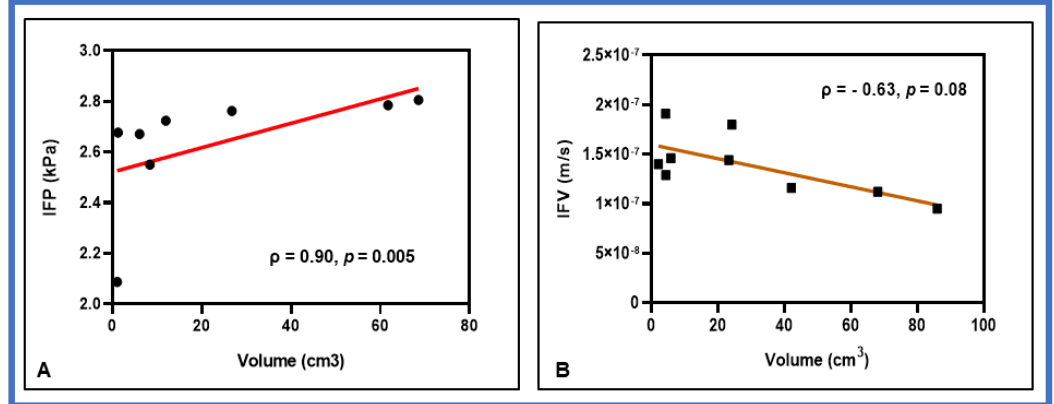
Figure 4. Representative correlation plots between CFM estimates of ( A ) interstitial fluid pressure (IFP) and tumor volume at pre-TX ( B ) interstitial fluid velocity (IFV) and tumor volume at D2-TX. IFP and IFV exhibited a strong positive and negative correlation with tumor volume at the respective time points. The solid red line represents the least square fit.